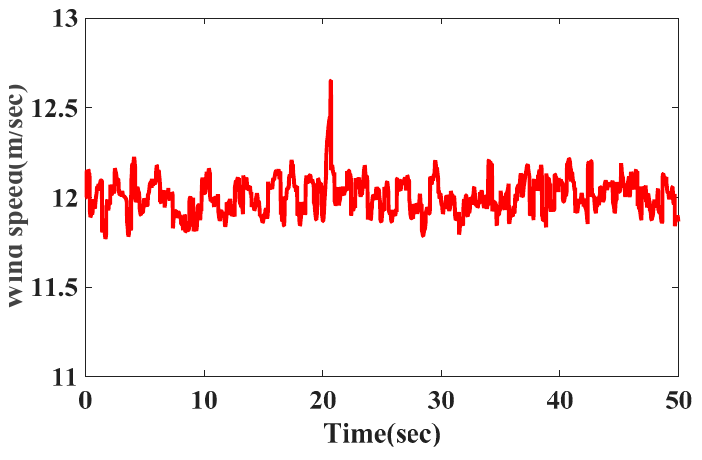
Figure 8. Wind speed variations.